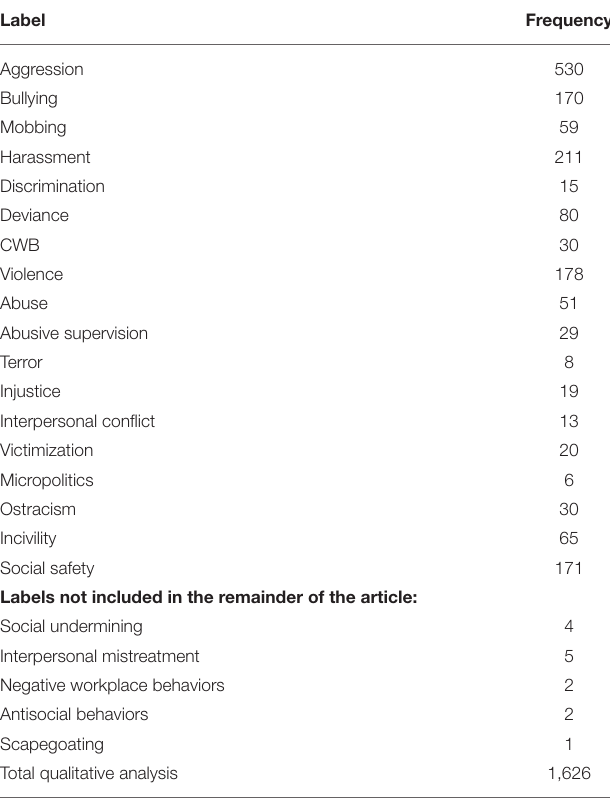
TABLE 1 | Frequency of NWB labels in study